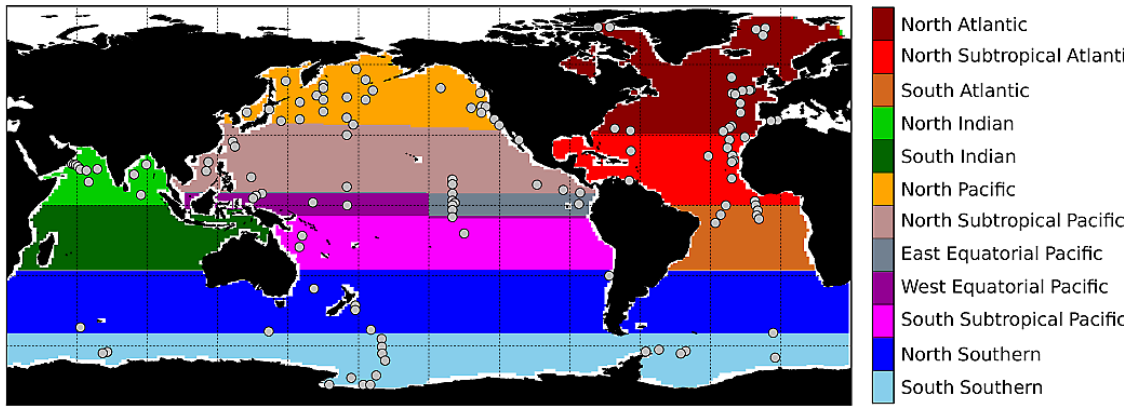
Fig. 1. CCSM–BEC model domain regions and location of sediment traps in the Lutz et al. (2007) data